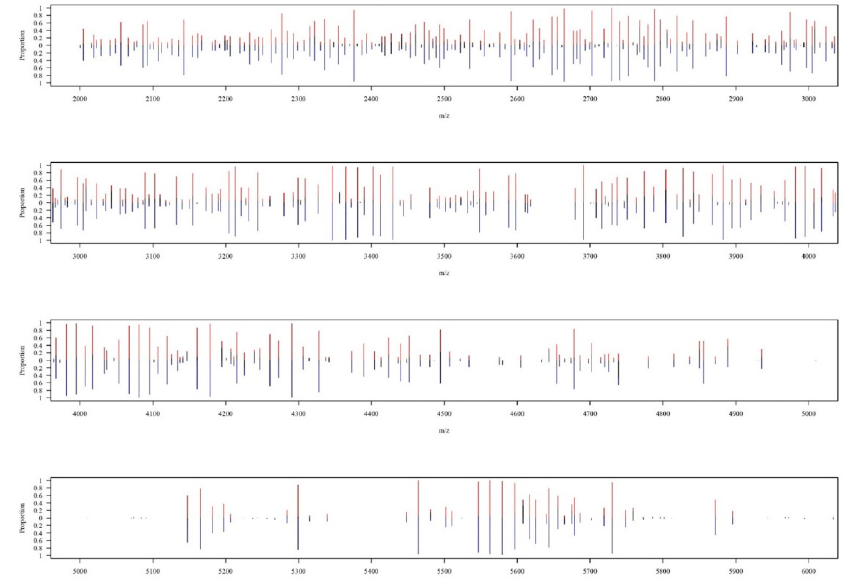
Figure 4. Zoomed-in view on MALDI–TOF spectrum over m / z 2000 to 6000. A zoomed-in detailed view over the range of m / z 2000 to 6000. The x -axis represents the mass-to-charge ratio ( m / z ) from 2000 to 6000. The y -axis shows the proportion of occurring frequency in all corresponding isolates at specific peaks, while red lines represent M. massiliense , and blue lines represent M. abscessus . For example, at peak of m / z 3008, red line (i.e., M. massiliense ) appears in about 60% of subsp. massiliense isolates, whereas the blue line (i.e., M. abscessus ) shows the occurring frequency is only 20%.